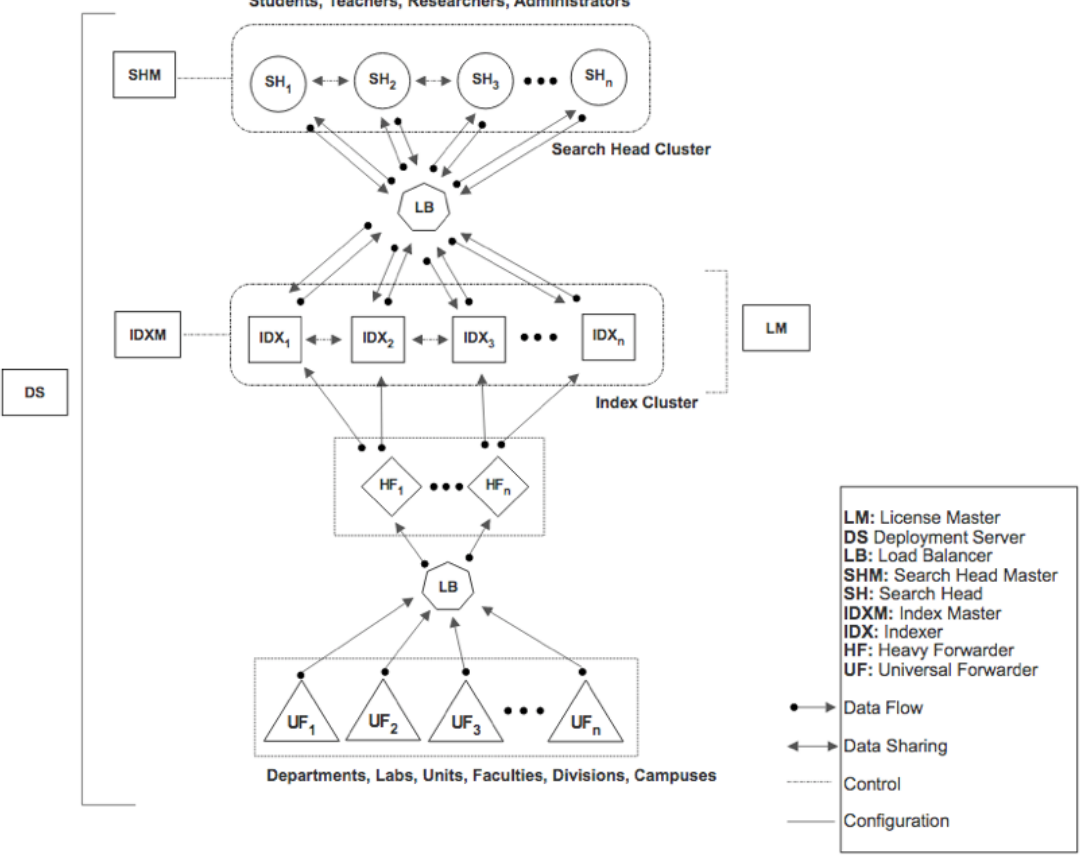
Figure 3. Splunk distributed-instance deployment